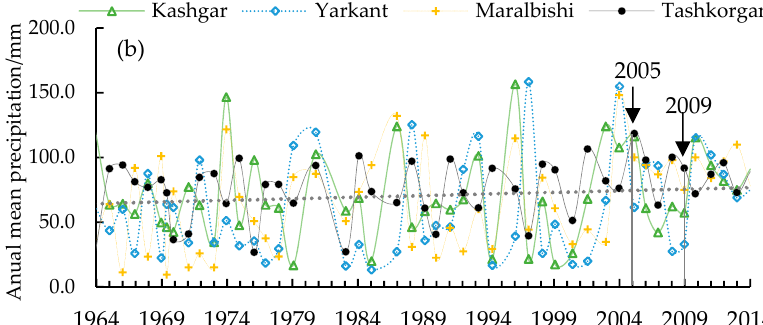
Figure 9. Runoff variation of Kashgar River ( a ); and Yarkant River ( b ).